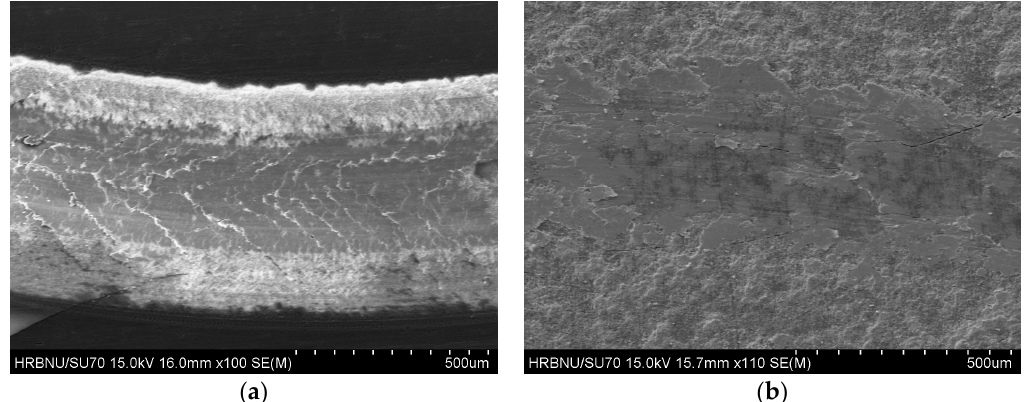
Figure 8. Electron microscopy photographs of wear marks: ( a ) Alumina film and ( b ) composite alumina film.